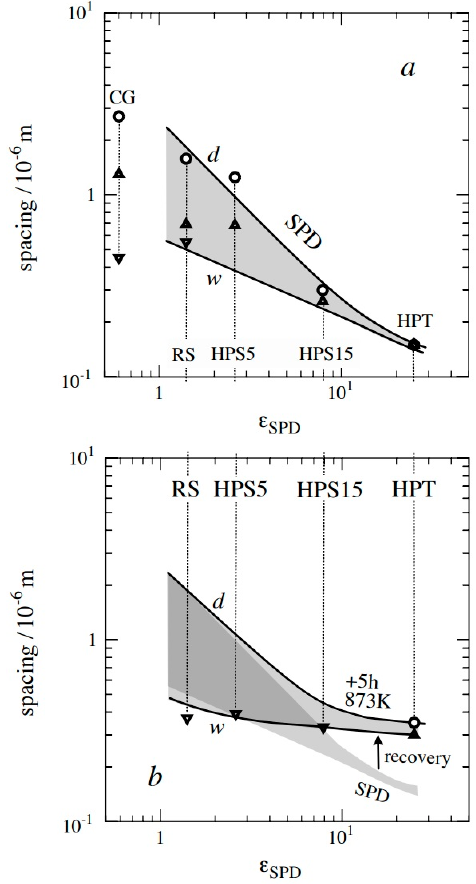
Figure 3. Boundary spacings d and w versus equivalent SPD strain ( ε SPD ) ( a ) after SPD and ( b ) after annealing; CG data are displayed at ε SPD = 0.6 for comparison reasons; the vertical extension of shaded area shrinks with increasing f HAGB